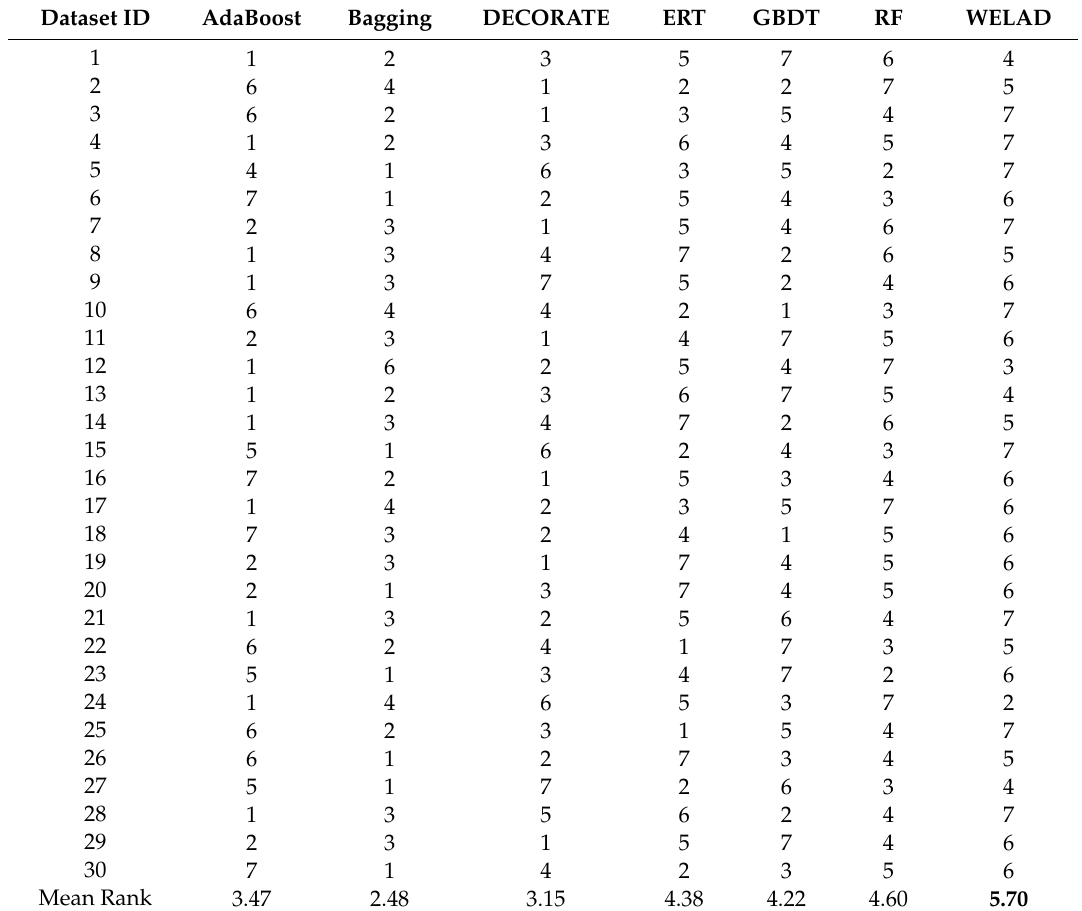
Table 4. Ranks of the Friedman test.